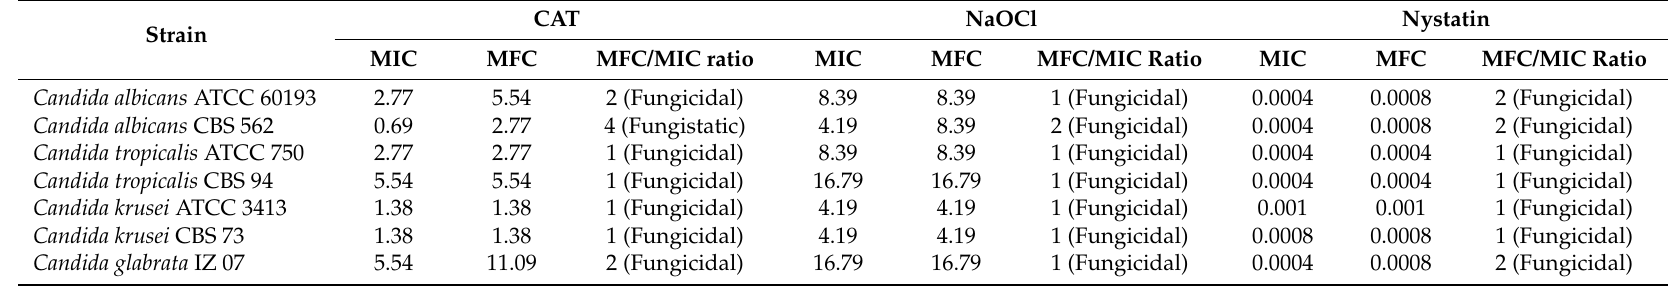
Table 1. Antifungal activity of chloramine T (CAT), sodium hypochlorite (NaOCl) and nystatin against Candida spp. strains. Values are expressed in mmol/L.